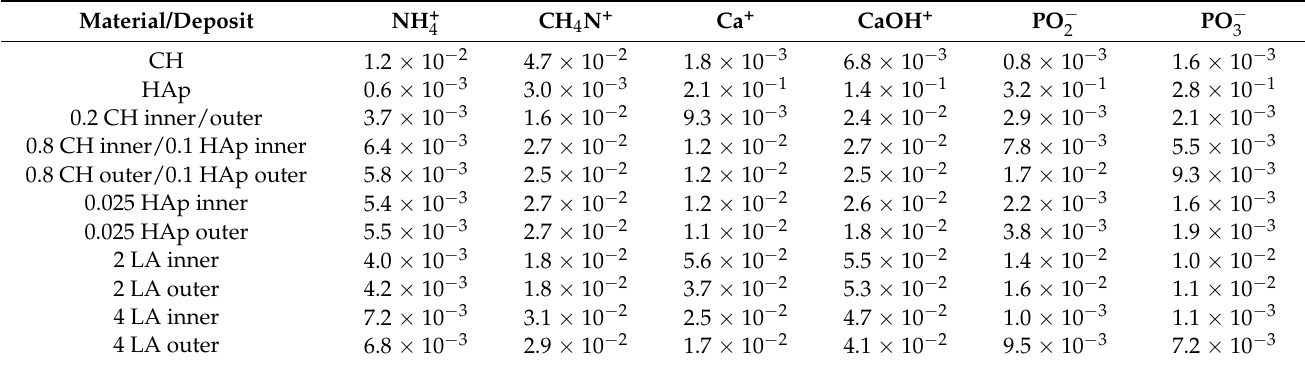
Table 3. Intensity of selected positive and negative secondary ions collected from chitosan (CH 85/500), hydroxyapatite, and surfaces of tubular-shaped chitosan–hydroxyapatite deposits. The solution concentrations are listed in Table 2.